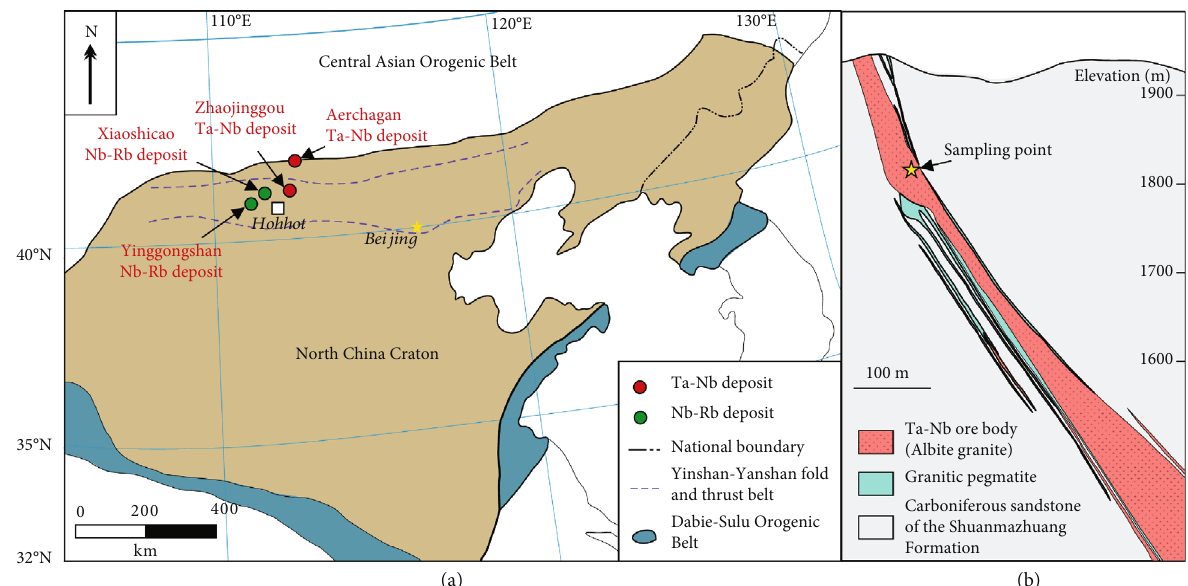
Figure 1: (a) Simpli fi ed geological map of the Zhaojinggou Nb-Ta deposit at the northern margin of the North China Craton (modi fi ed from Zhu true [27]). (b) Cross section of the Zhaojinggou Ta-Nb deposit (modi fi ed from Chai and Wu [31]).